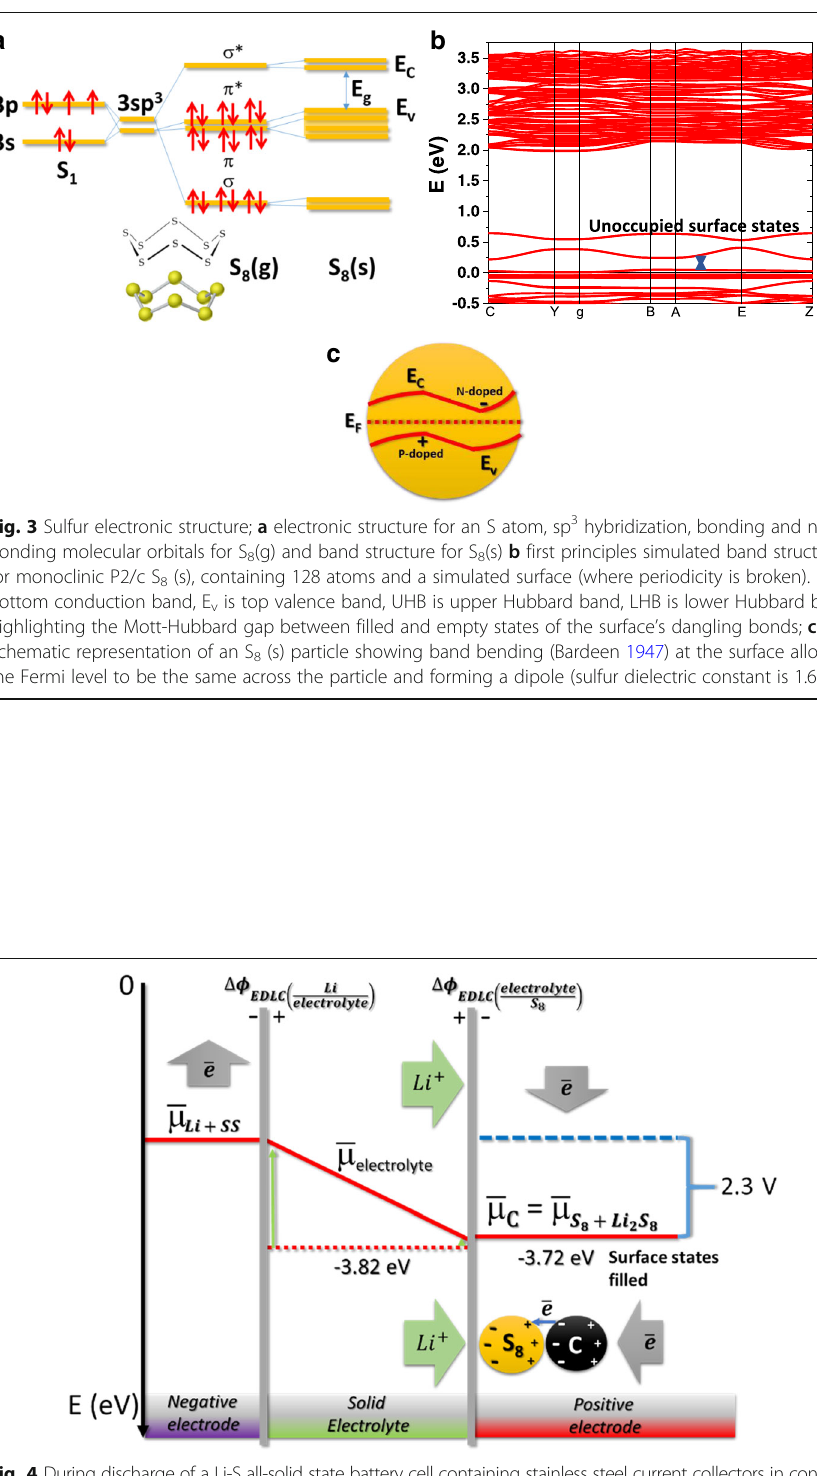
Fig. 4 During discharge of a Li-S all-solid state battery cell containing stainless steel current collectors in contact with both electrodes, lithium negative electrode, sulfur S 8 and carbon positive electrode and copper or aluminum positive current collector. If the electrochemical potential of the positive electrode increases until it overcomes − 3.82 eV, the EDLC charges flip in order to equalize the electrochemical potentials and more Li-ions are attracted to the electrolyte interface with the positive electrode. We do not consider the energy lost by the Joule effect due to the resistances inside the cell